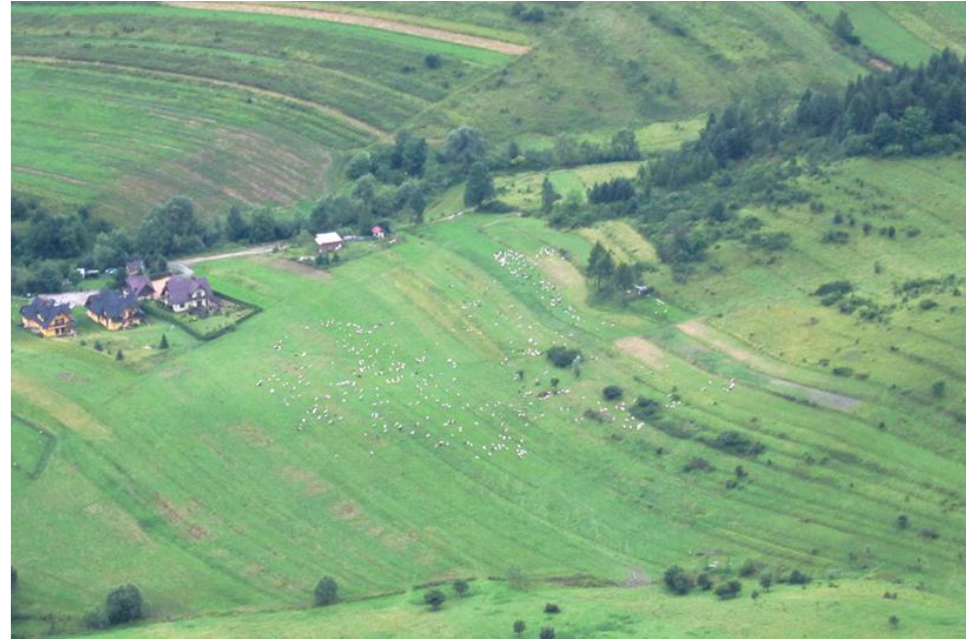
Figure 1. Grazing on former arable land in the Pieniny Mts.